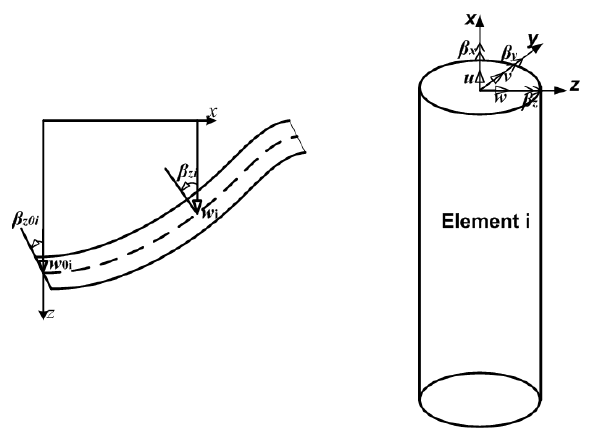
Figure 2 . Displacement of a